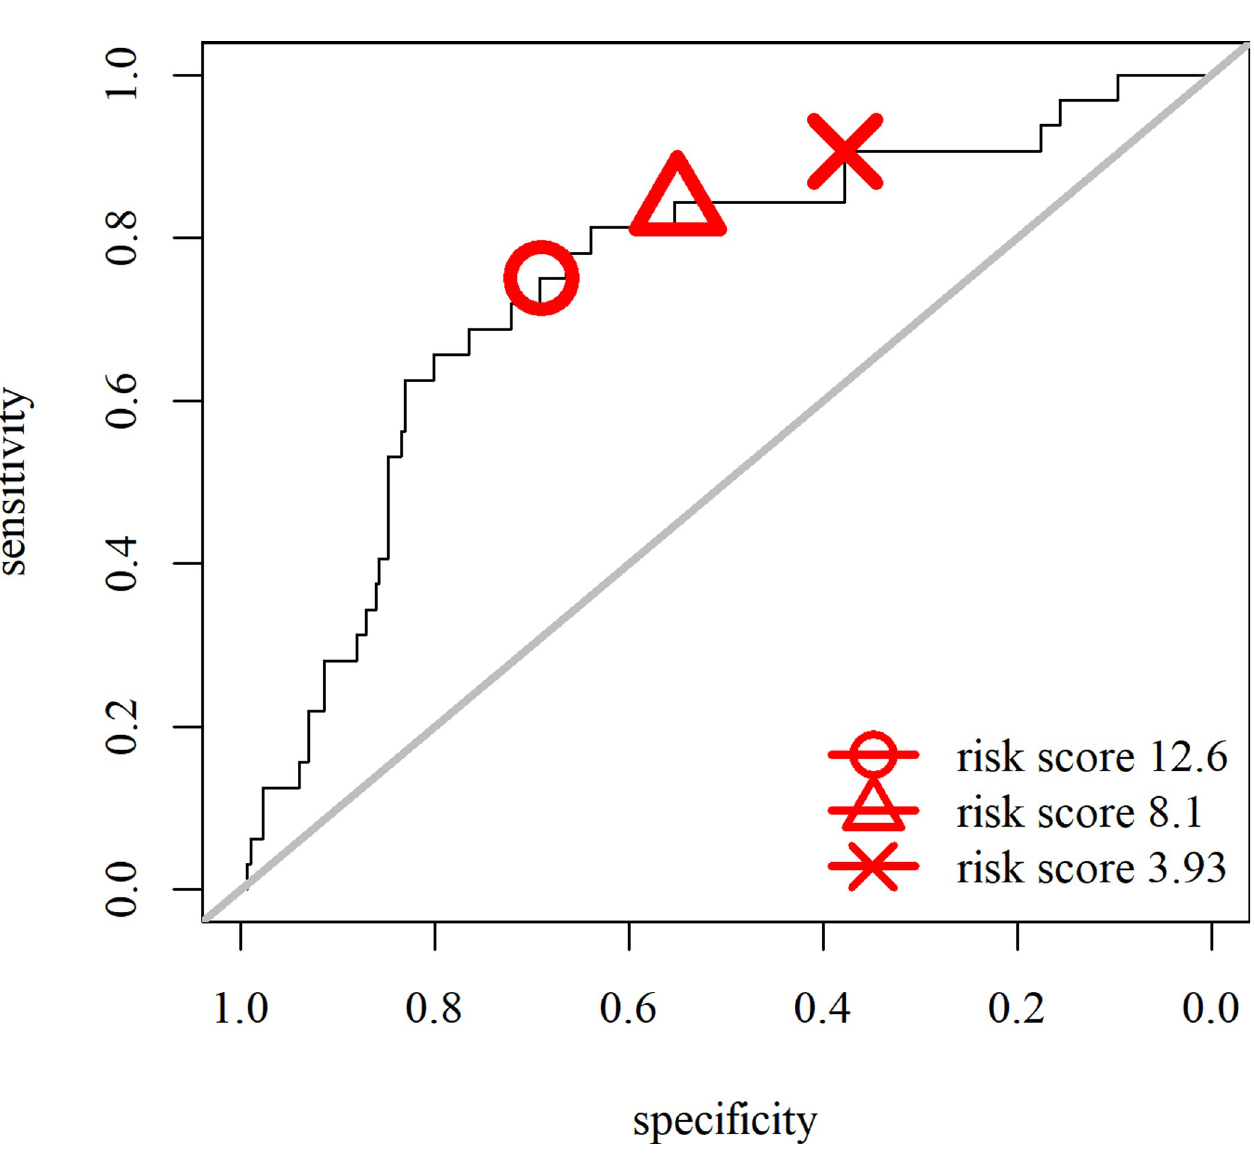
Fig 4. Sensitivity and specificity scores for different cut-offs for the final model with Age + C-Barrett length + normalized clone score over markers CEP7, CEP17, 20q and c-MYC. The red symbols indicate the cut-off risk scores to stratify in a high and low risk group as plotted in the Kaplan Meier curves in Figs